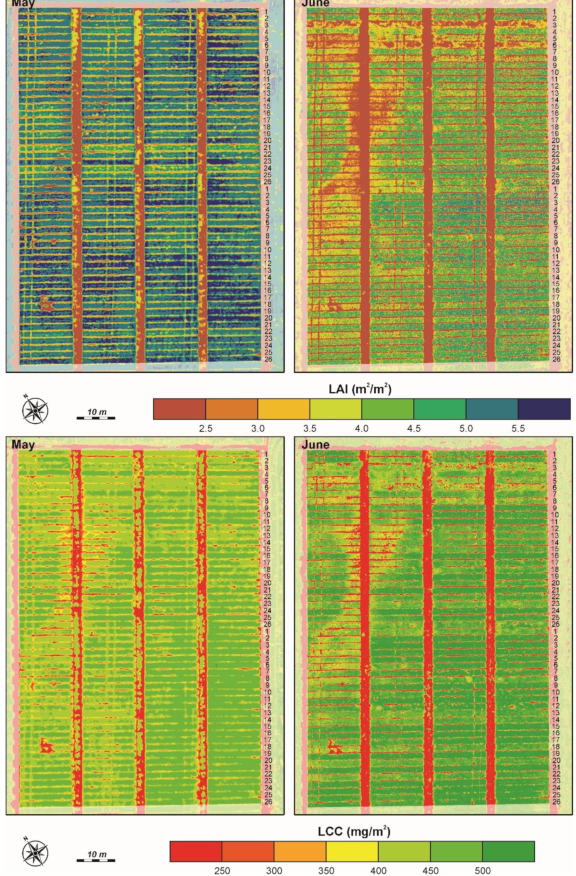
Figure 8. UAV-obtained map of estimated LAI and LCC for both CVTs for flowering (May) and grain filling (June) phenological development stage. The LAI and LCC are estimated with the GPR model. The uncertainty is characterised by the mean coefficient of variation (CV) generated by each GPR model. The mean and standard deviation of CV for LAI05 are much lower than those for LAI06: 16%, 1% and 28%, 12%, respectively. The mean and standard deviation of CV for LCC05 and LCC06 are almost constant: 8%, 0.5% and 10%, 2.6%,